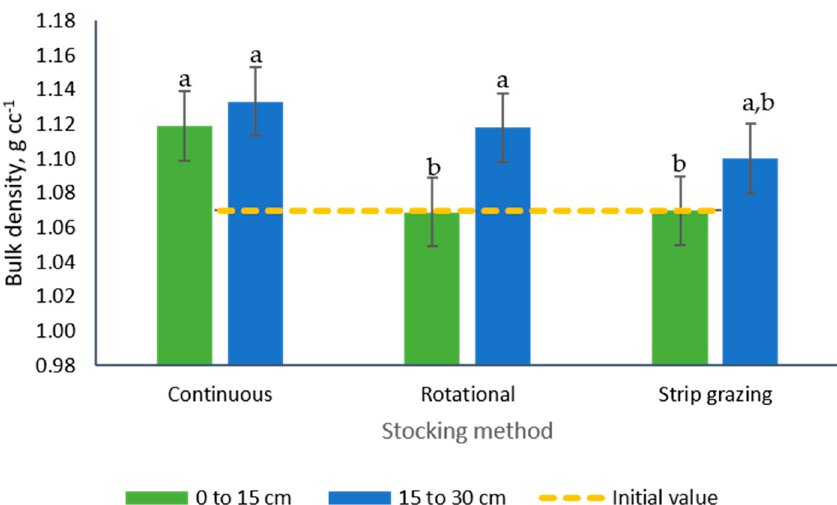
Figure 8. Interaction of stocking method and soil sampling depth on the bulk density of soils from tall fescue paddocks managed with growing-finishing pigs. a, b: means displaying the same letter are not significantly different at the 5% level of probability as indicated by the Multiple Comparisons test—simulate option. Data are the means of three field replicates. Errors bars represent plus or minus one standard error of the means for the interaction.